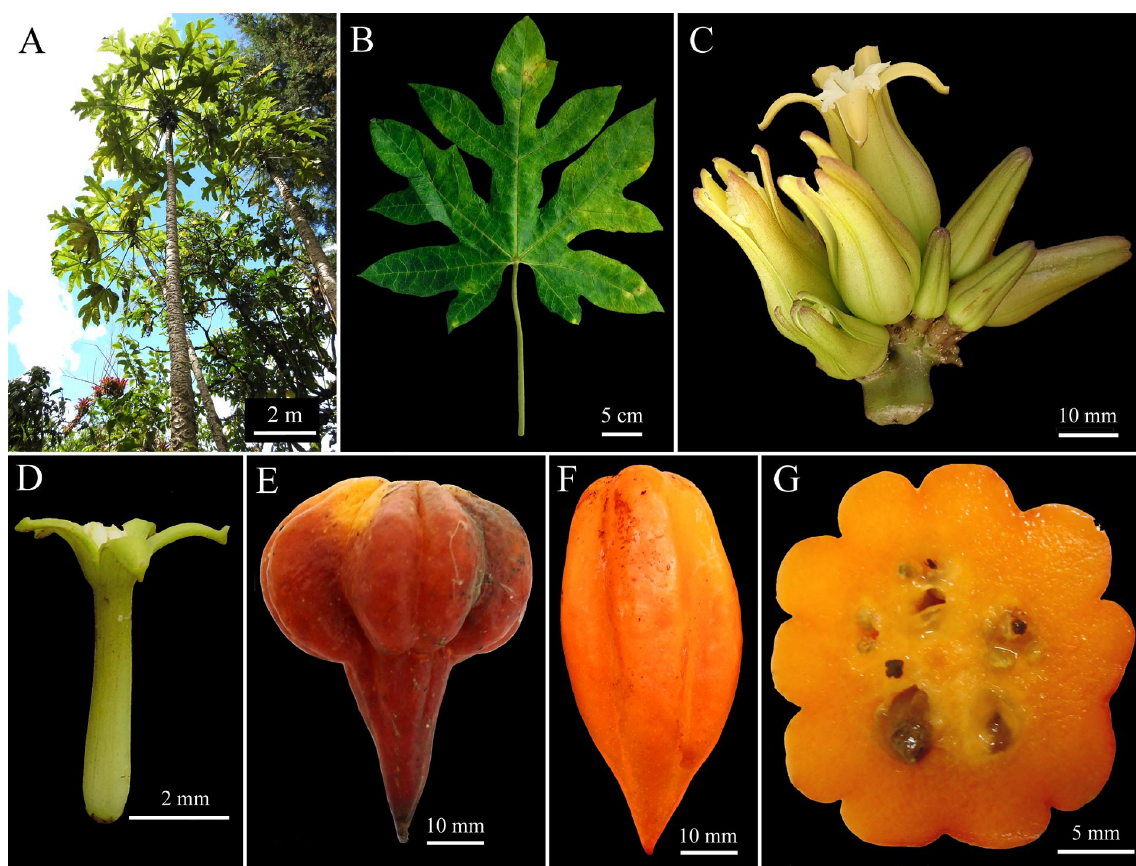
Fig 5. Morphology of Vasconcellea chachapoyensis sp. nov. (CHAX235). A, Habit. B, Palmately compound leaf. C, Female inflorescence. D, Male flower. E, F, Mature fruits with acuminate apex. G, 5-locular